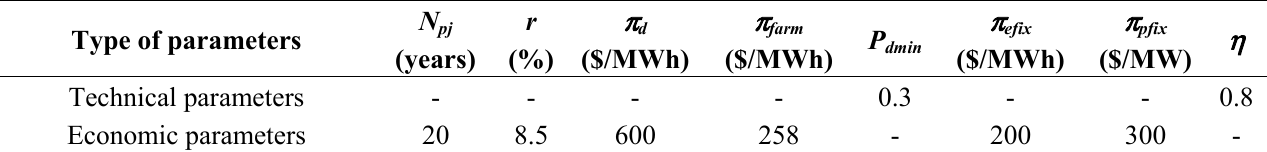
Table 1. Main technical-economic parameters affecting the energy storage sizing: reference